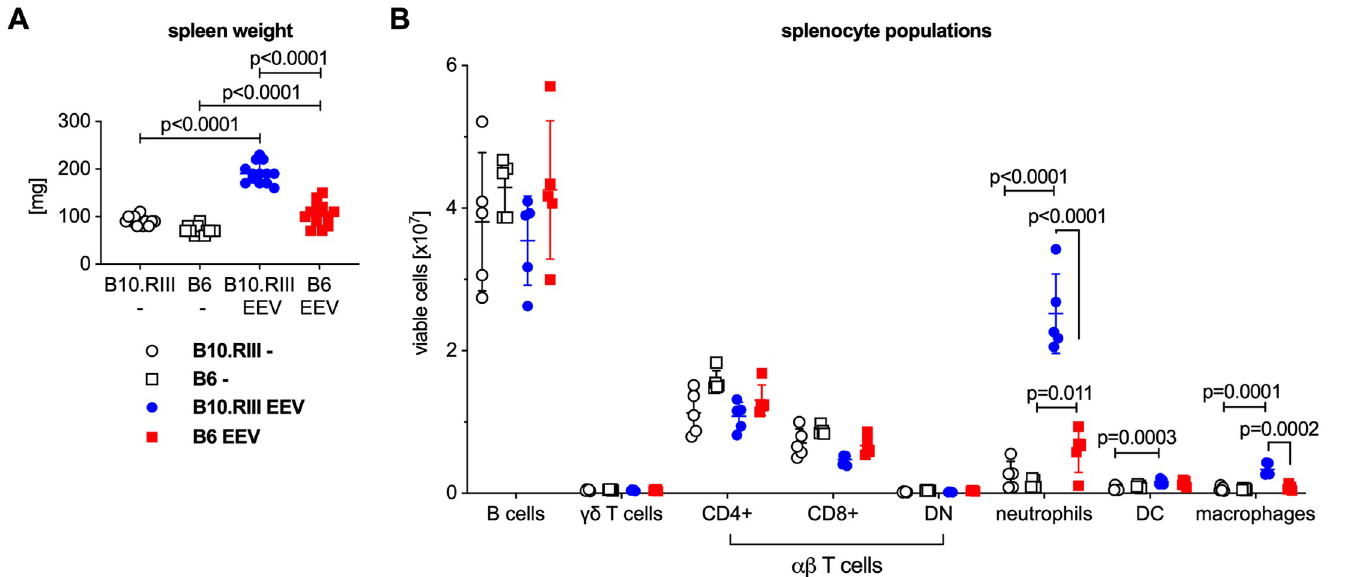
Fig 6. Male B6 mice accumulate significantly fewer myeloid cells than B10.RIII mice in the spleen after hydrodynamic injection of IL-23 EEV. (A) Spleen weight of the mice from the experiment in Fig 4. (B) For a subset of animals, single cell suspensions were prepared from the spleens and analyzed by flow cytometry, n = 5 mice/group. P values were determined by unpaired